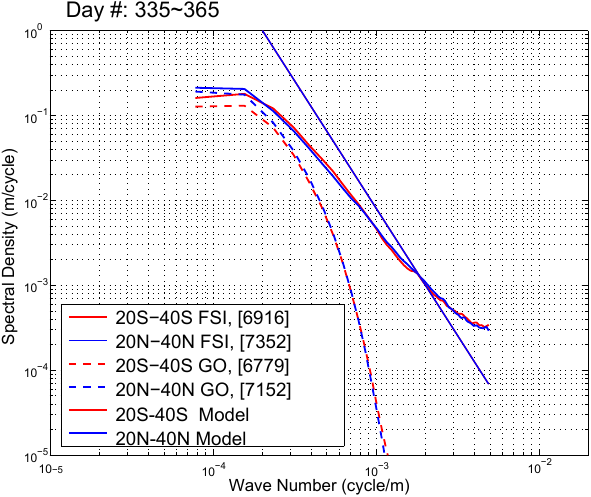
Fig. 5. Mean vertical wave number spectra of the normalized tem- perature perturbations at 20–30km altitude in October–December 2006. The green and orange lines correspond to the spectra using the FSI and GO retrievals, respectively. The red line is an average spectrum from 231 radiosonde profiles obtained in North America. The dashed blue line indicates the model spectrum for large wave numbers with N 2 = 4 . 67 × 10 − 4 (rad 2 s − 2 ) .